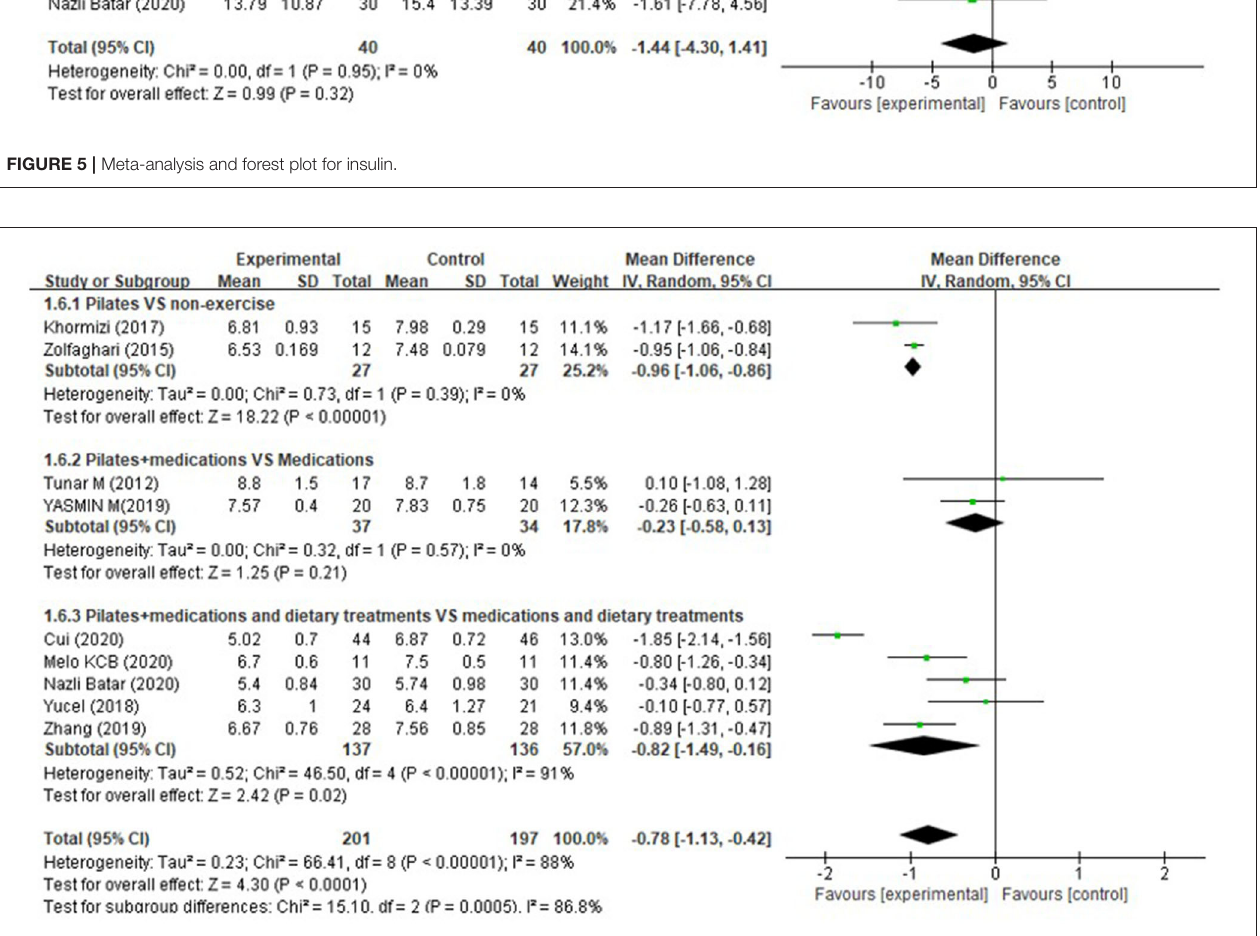
FIGURE 6 | Meta-analysis and forest plot for glycated hemoglobin (HbA1c). − 5.53 mg/dL, 95% CI: [ − 14.71, 4.01] mg/dL, P = 0.26, I 2 =